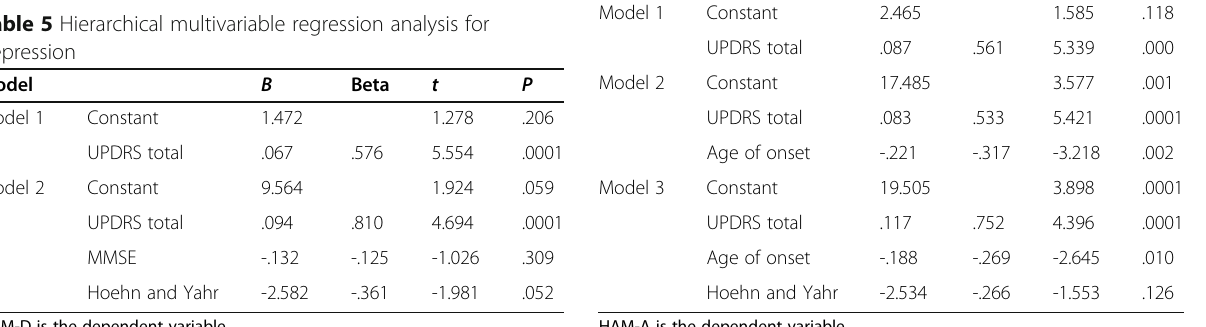
Multiple regression analysis results